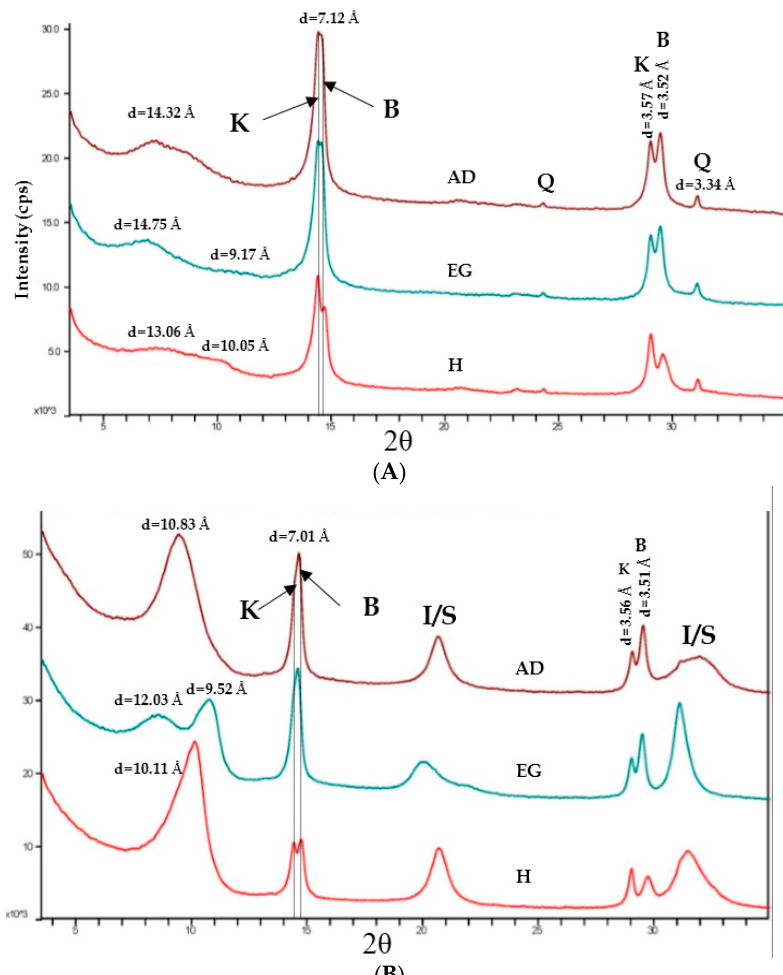
Figure 4. XRD patterns for air-dried, EG-solvation, and heated clay fractions of selected samples ( A ) X-2 and ( B ) L-19. Abbreviations are same as in Figure 3. AD: air-dried; EG: ethylene glycol saturated; H: heated.